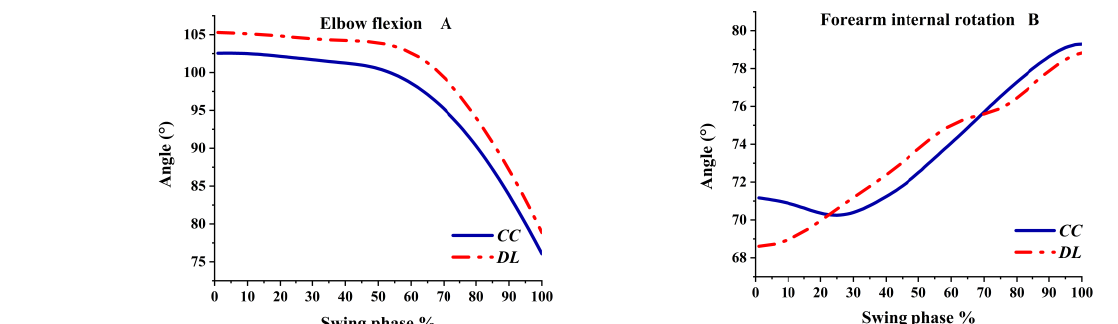
Figure 4. Elbow angles during the swing phase.